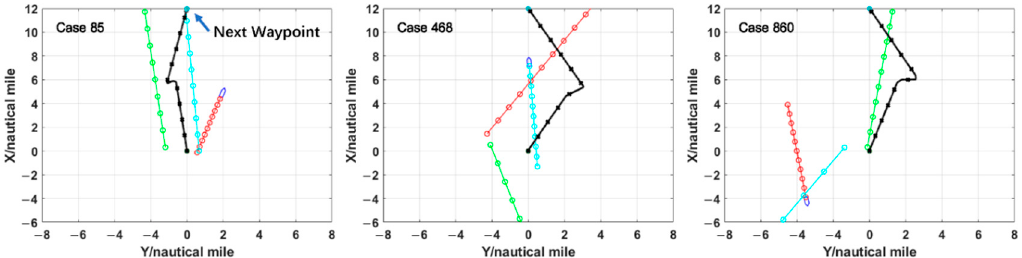
Figure 20. The successful examples on “parallel problem”.